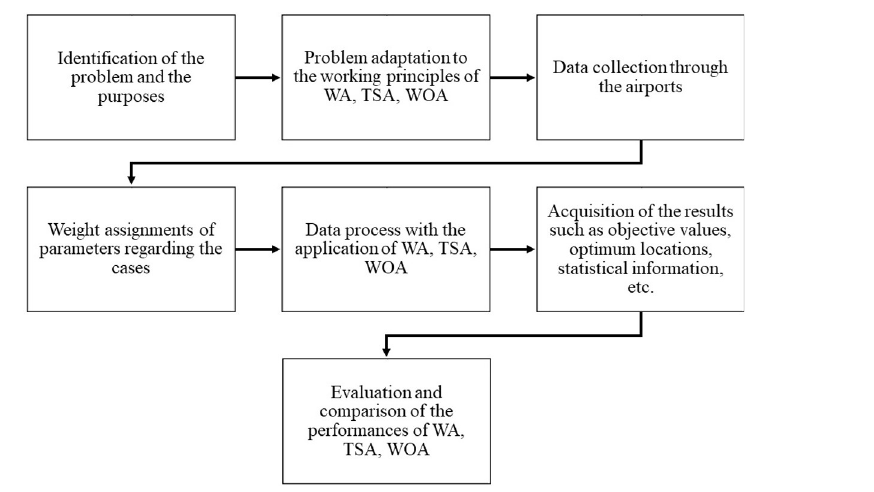
Fig 3. Present work procedure flowchart.